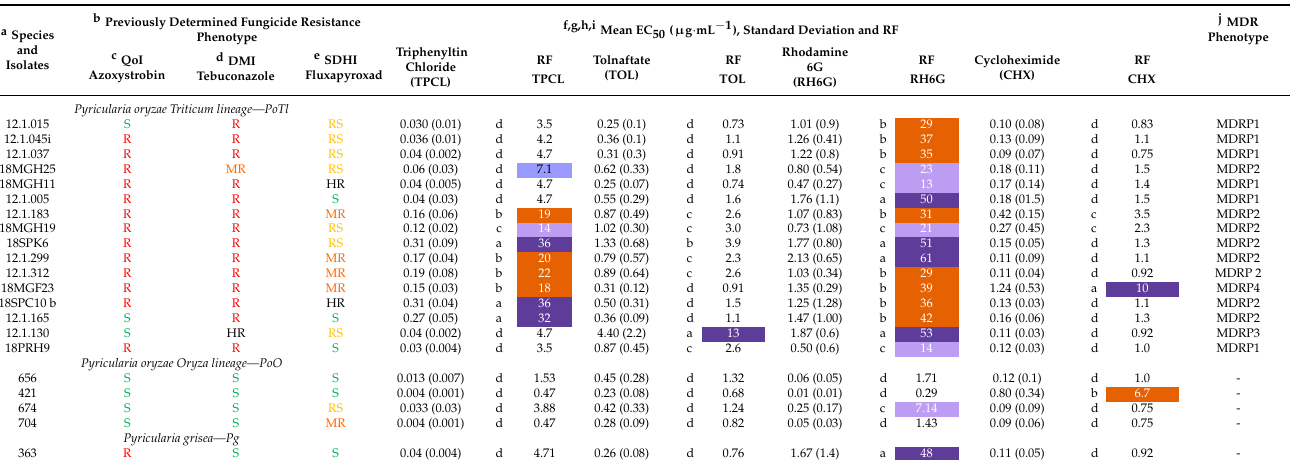
Table 2. Field isolates of Pyricularia spp. sampled in Brazil in 2012 and 2018 and respective resistance phenotype classes to three major fungicide classes and sensitivity to efflux pump substrates and respective resistance factors.